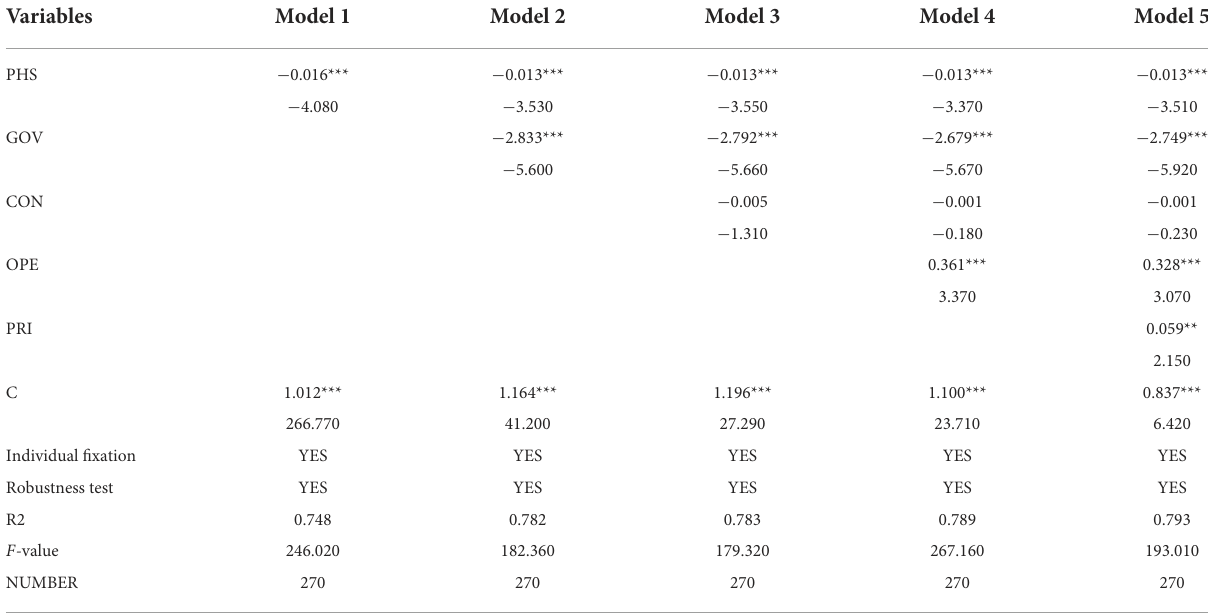
TABLE 7 Panel model regression